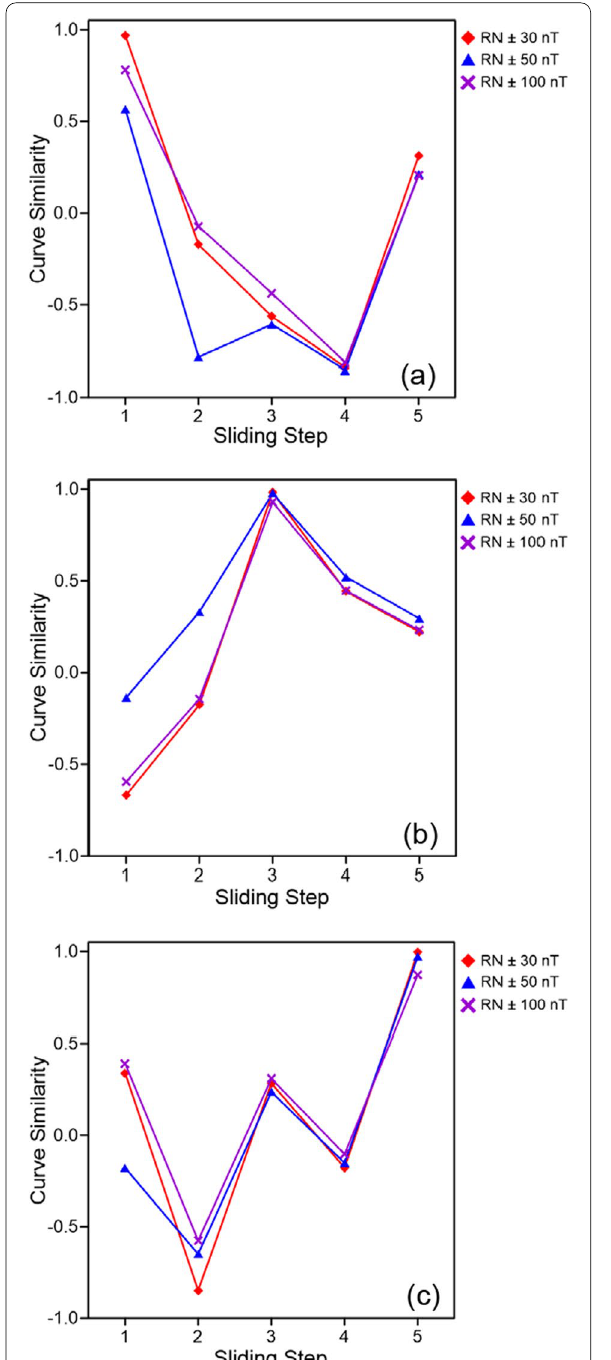
Fig. 12 Identification results of the polarity chron C27, C28 and C29 under different random noises. a The identification results of the polarity chron C27. b The identification results of the polarity chron C28. c The identification results of the polarity chron C29